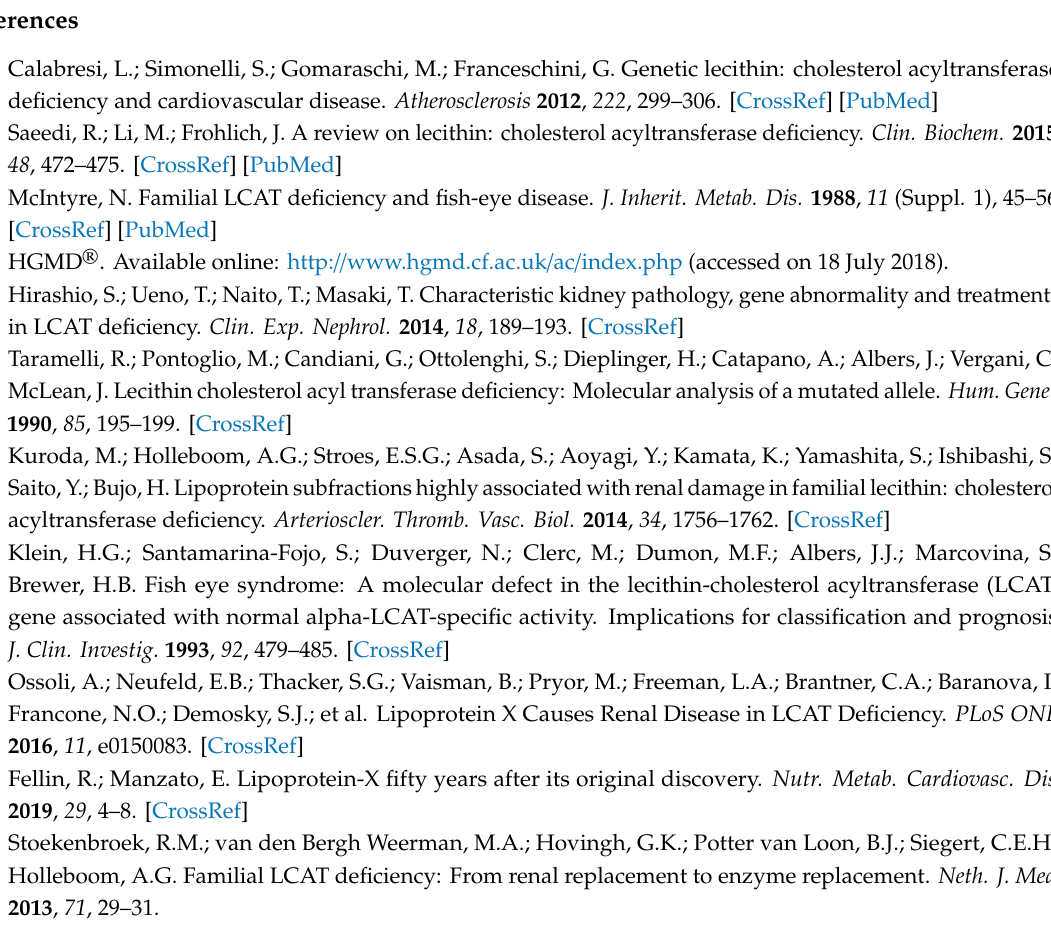
Figure S1: Agarose gel electrophoresis and lipid staining of the plasmas of the family kindred of the first (I.1) and the second (I.3) cases, Figure S2: 1 H-NMR spectra region of serum lipids highlighting the signals of free cholesterol (FC) and esterified cholesterol